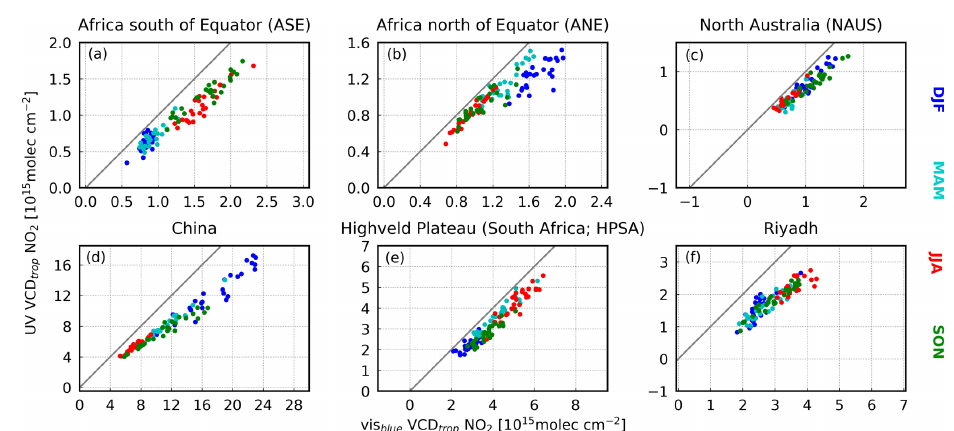
Figure 16. Scatter plot of tropospheric UV NO 2 VCDs against tropospheric vis blue NO 2 VCDs for the period 2007–2015 for the six selected regions. Note the different axes. The seasons are colour-coded. The related correlation, slope, and intercept of the regression line can be found in Tables 6 and 7. December, January, February: DJF; March, April, May: MAM; June, July, August: JJA; September, October, November: SON. Table 7. Slope and intercept between UV NO 2 VCDs and vis blue NO 2 VCDs for the six selected regions. Intercept in 1e15moleccm − 2 . In the brackets the standard errors for both values are shown. Region Annual DJF MAM JJA SON ASE